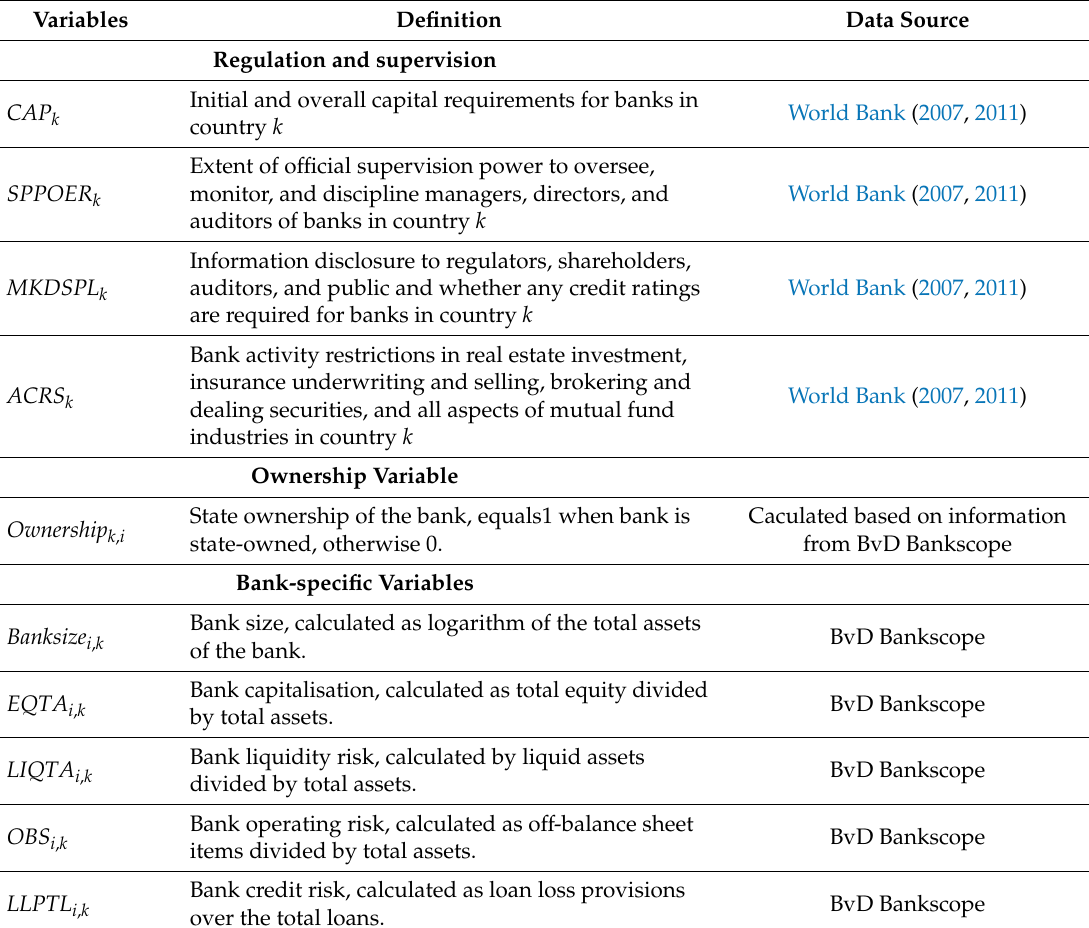
Table A1. Definition and data source of variables used in the regression